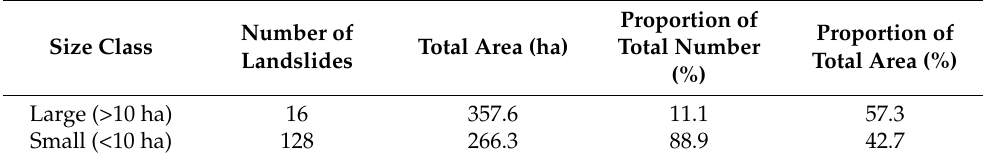
Table 2. Magnitude characteristics of the landslides in the Xiaolin area